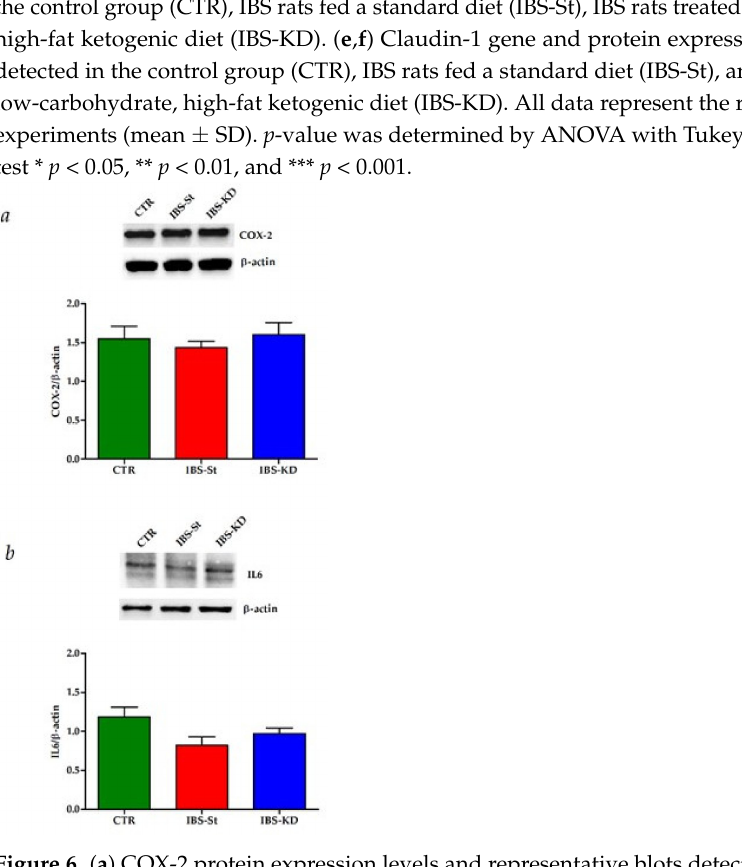
Figure 6. ( a ) COX-2 protein expression levels and representative blots detected in the control group (CTR), IBS rats fed a standard diet (IBS-St), and IBS rats treated with low-carbohydrate, high- fat ketogenic diet (IBS-KD). ( b ) IL-6 protein expression levels and representative blots detected in the control group (CTR), IBS rats fed a standard diet (IBS-St), and IBS rats treated with low- carbohydrate, high-fat ketogenic diet (IBS-KD). All data represent the results of three different experiments (mean ± SD). p -value was determined by ANOVA Tukey’s multiple comparison